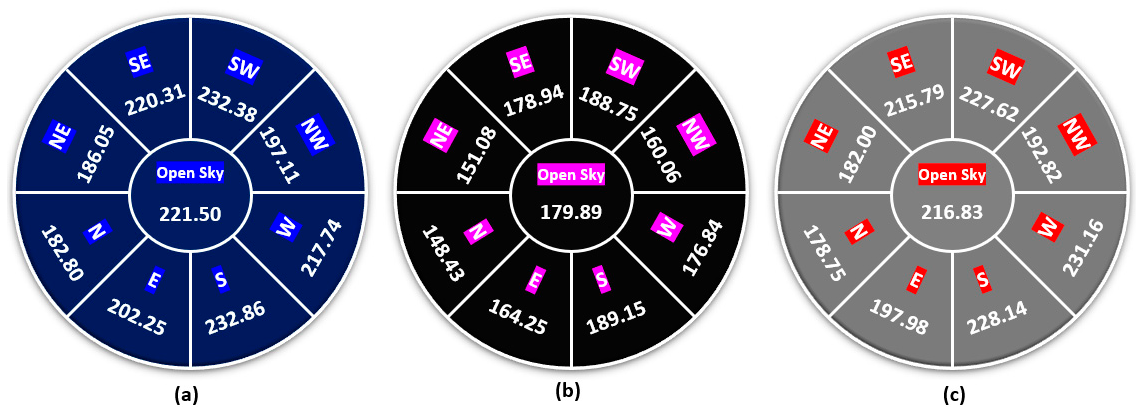
Figure 10. Comparing the solar PV leaves’ annual energy outputs based on their installation orientation: ( a ) c-Si solar cell technology; ( b ) CIGS solar cell technology; ( c ) CdTe solar cell technology.